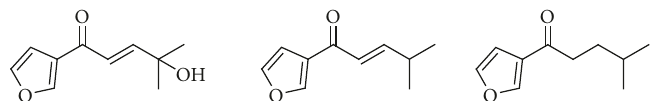
Figure 1: Chemical structures of compounds 1 – 3 extracted from the leaves of P. frutescens var. crispa (cv.